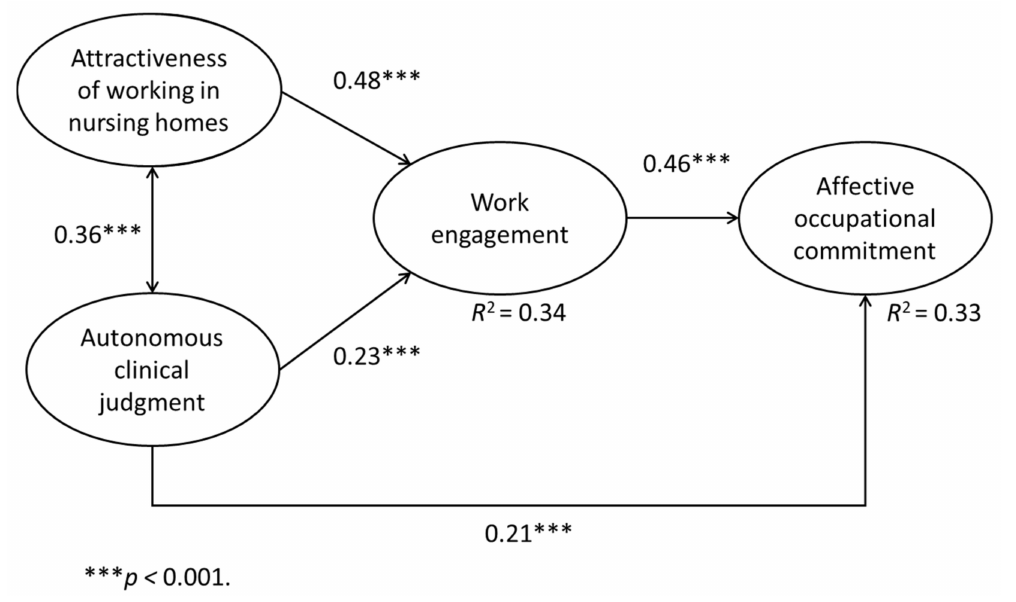
Figure 2. Final motivational process model for this